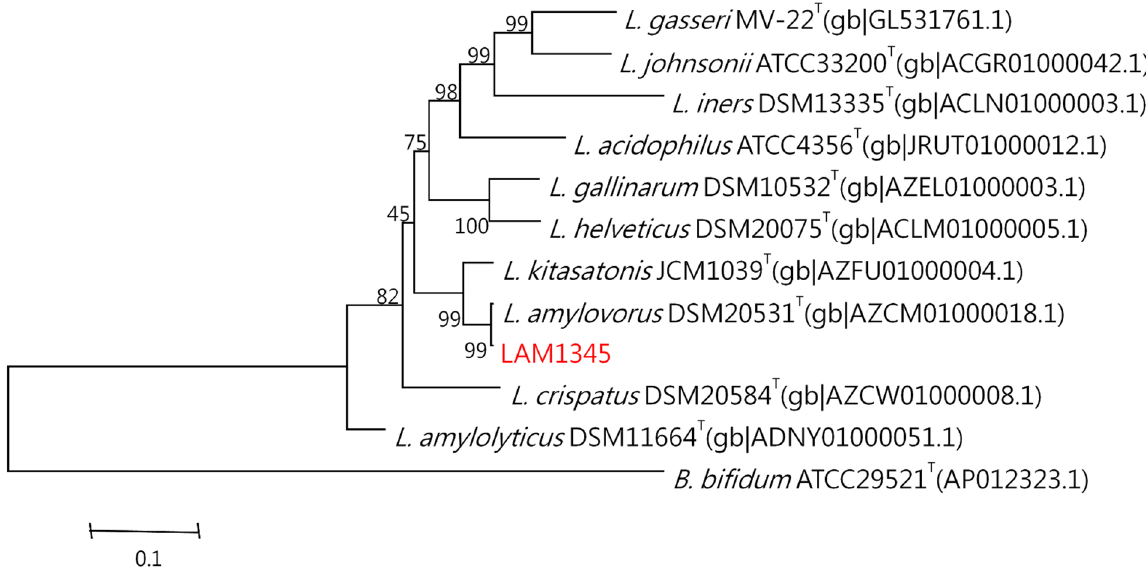
Figure 6. Phylogenetic tree of the lepA gene of strain LAM1345 strain and related lactobacilli species.